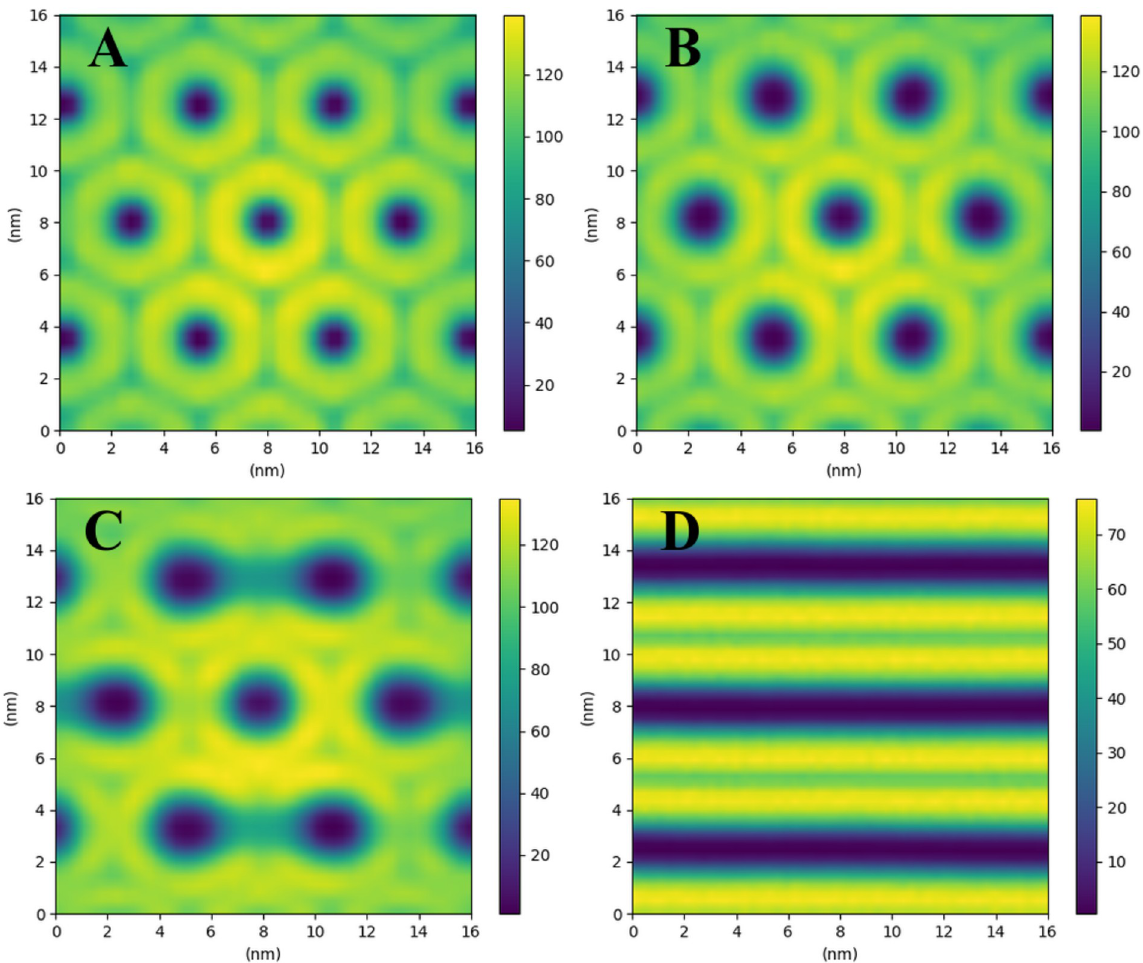
Fig 10. The cross-sectional 2D histogram of the systems of 1000 CG lipid molecules taken perpendicularly to the structures formed (see Fig 7) at various water contents of (A) 12 wt%, (B) 18 wt%, (C) 26 wt%, (D) 32 wt%. The central cylinder going through diagonal of the box has the largest length, which makes it looking more